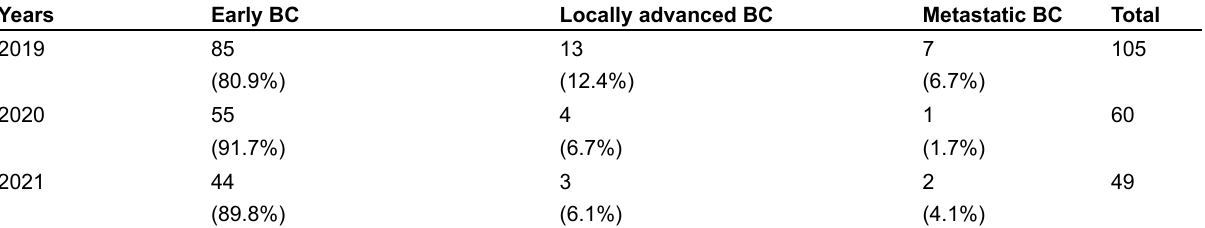
Table 5. Number and percentage of BCs diagnosed from 2019 to 2021, divided per stage Years Early BC